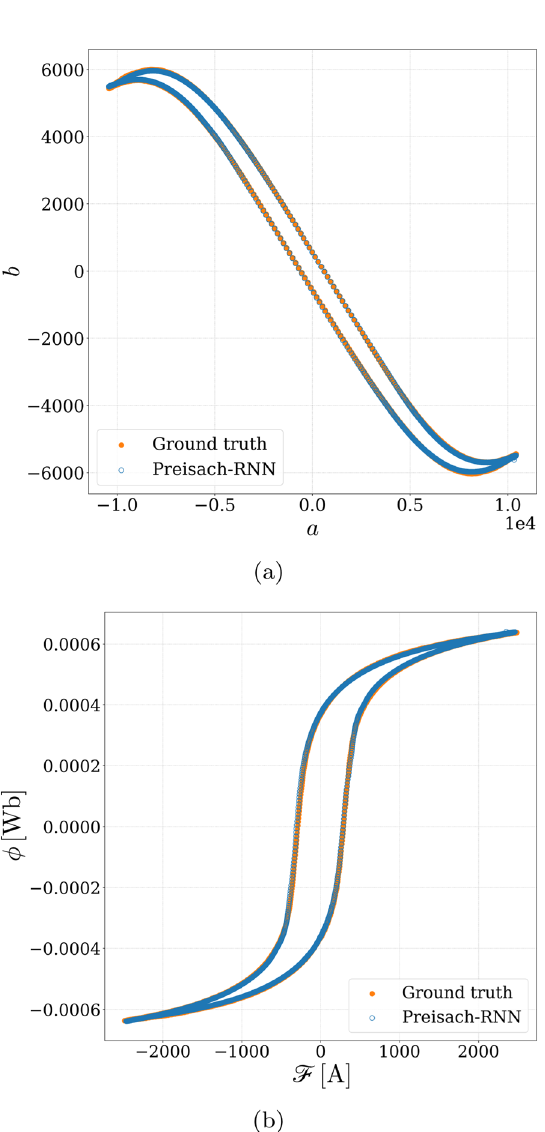
Fig. 9 a Predictions of a Preisach-RNN in the WD domain with U = 32 hidden units and M = 8 Play Operators (blue) vs. the ground truth (orange). Input rate: f = 20Hz . b WD predictions transformed into Kirchhoff domain variables by means of (36)